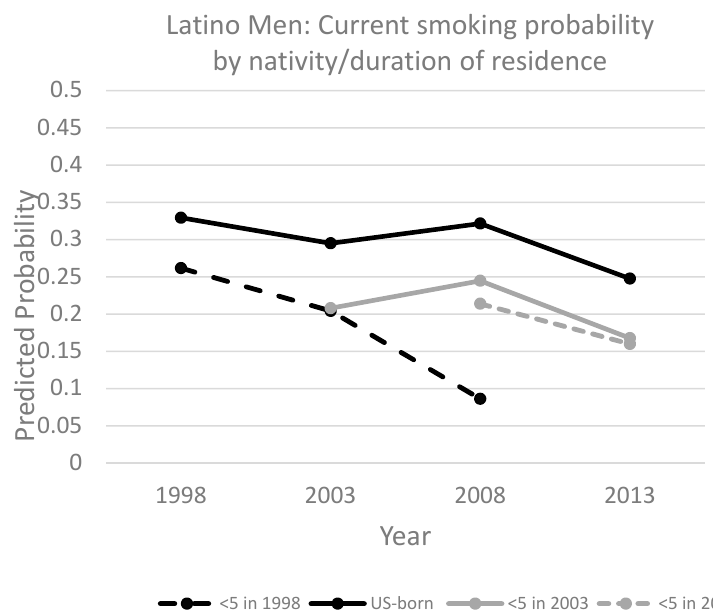
Figure 1. Predicted prevalence of current smoking among Latino men, comparing U.S.-born and immigrants by arrival cohort (cohort tracking method). Data come from U.S. NHIS, 1998–2013 [21].